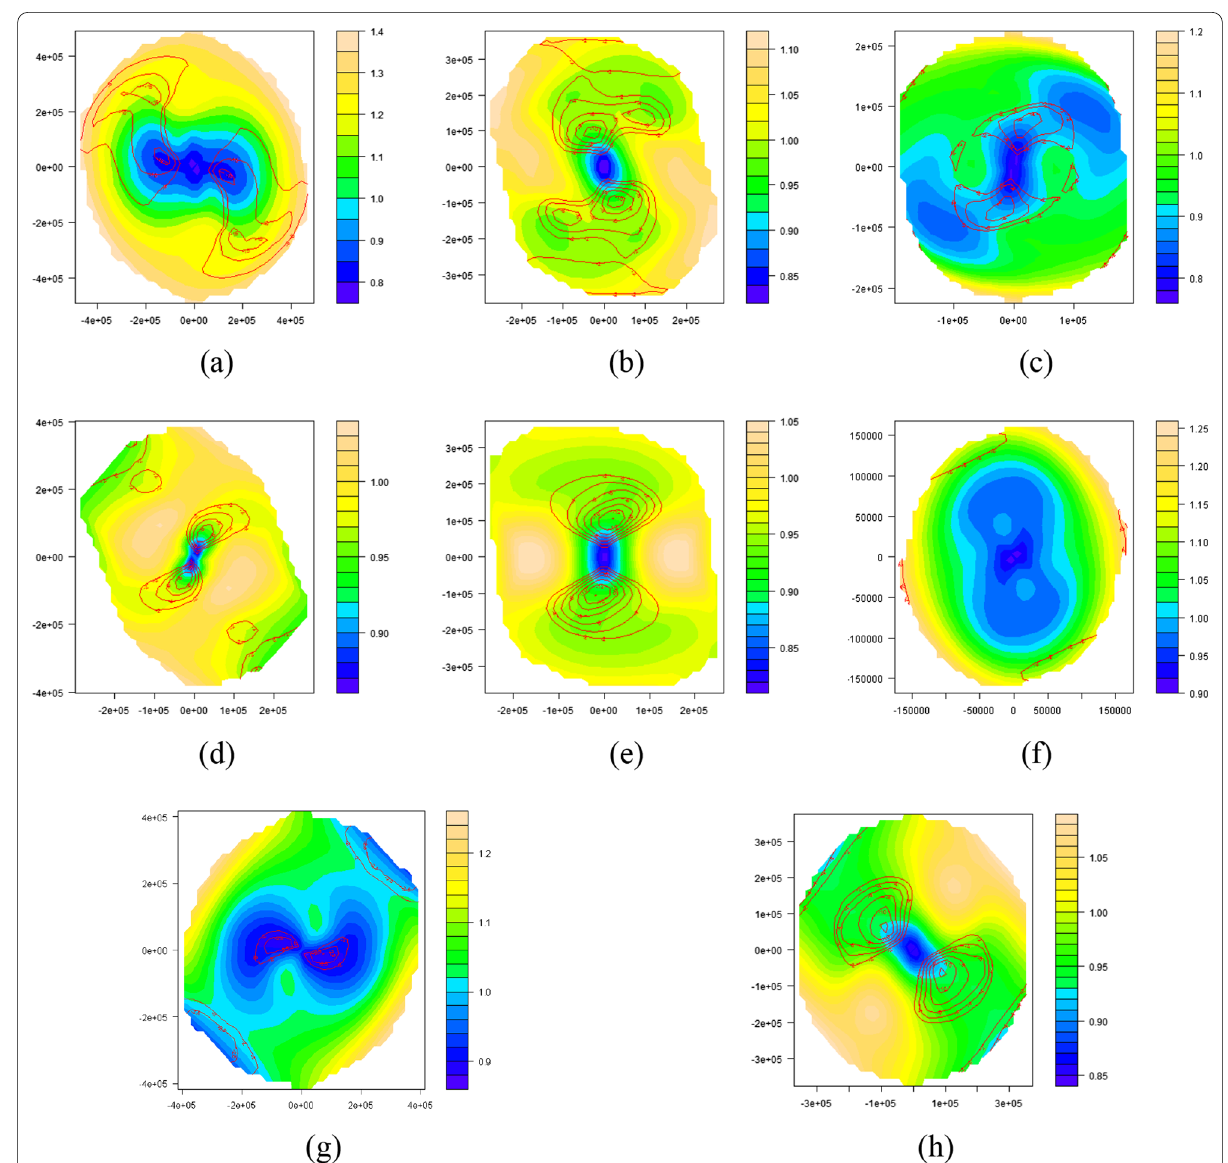
Fig. 3 Smoothed variogram of residuals of PGV at record stations of different earthquakes; a Chi-Chi, b Chuetsu, c El Mayor, d Iwate, e Niigata, f Northridge, g Parkfield, h